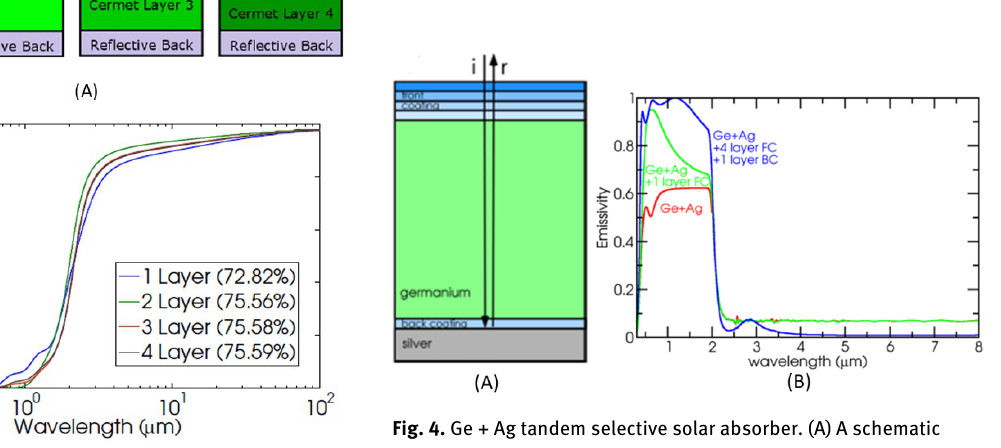
Fig. 4. Ge + Ag tandem selective solar absorber. (A) A schematic drawing of the optimized Ge + Ag tandem selective absorber with four front coating layers and a back coating of low index material. (B) Simulated emissivity spectrum showing that the front coating and back coating improve the overall emissivity before the cutoff wavelength while suppressing the parasitic emissions. Panels (A) and (B) adapted with permission from [50]. © 2010 Optical Society of